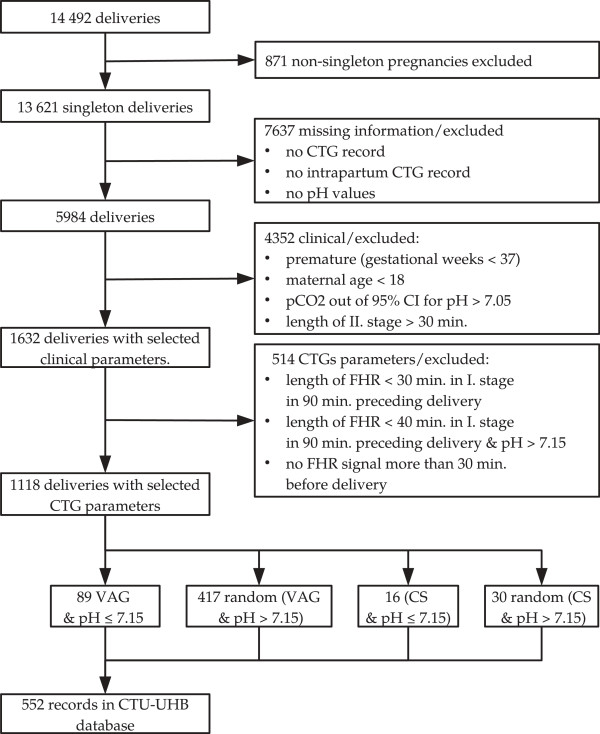
Selection of recordings for the final database. Flowchart diagram describing the process of data selection for the final database.